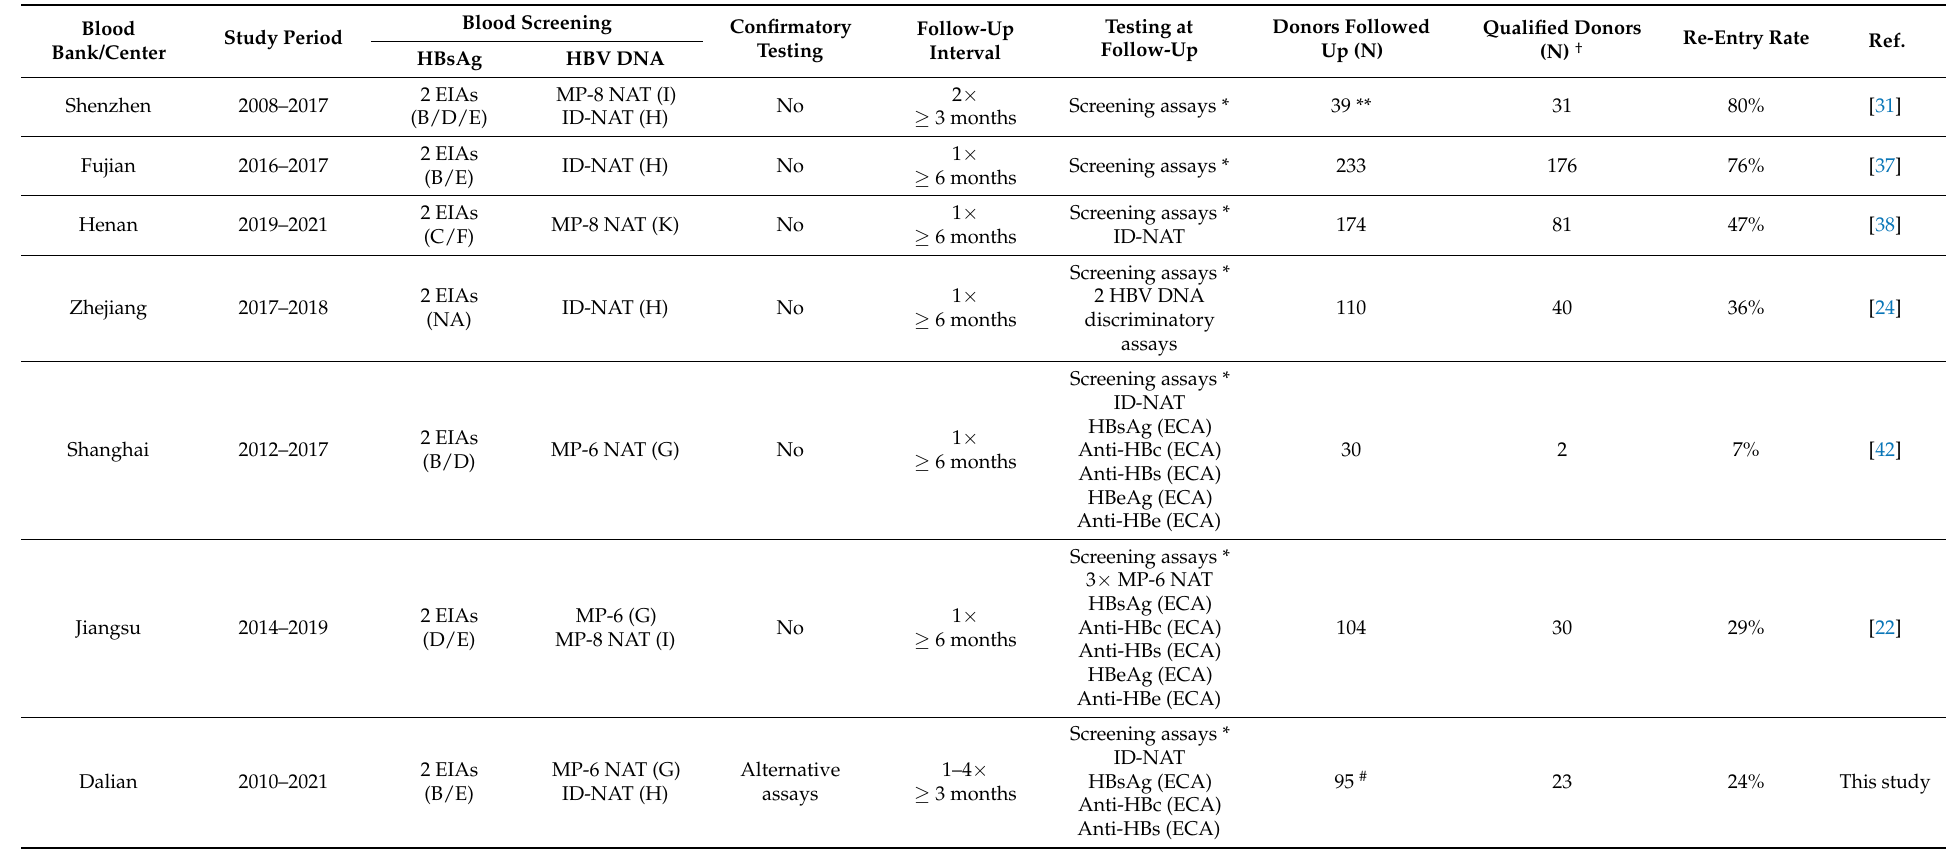
Table 3. Re-entry of HBV NAT-yield